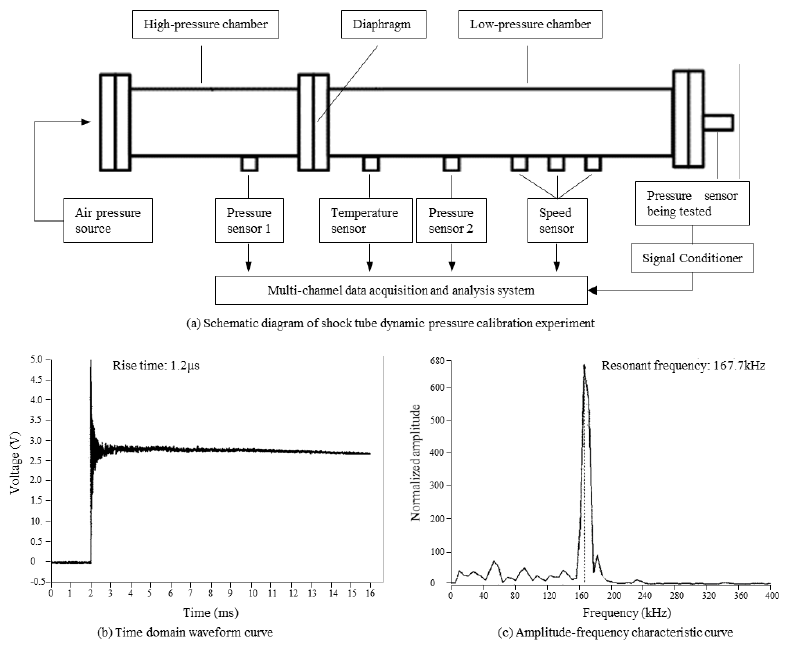
Figure 11. ( a – c ) Dynamic pressure calibration test and results.